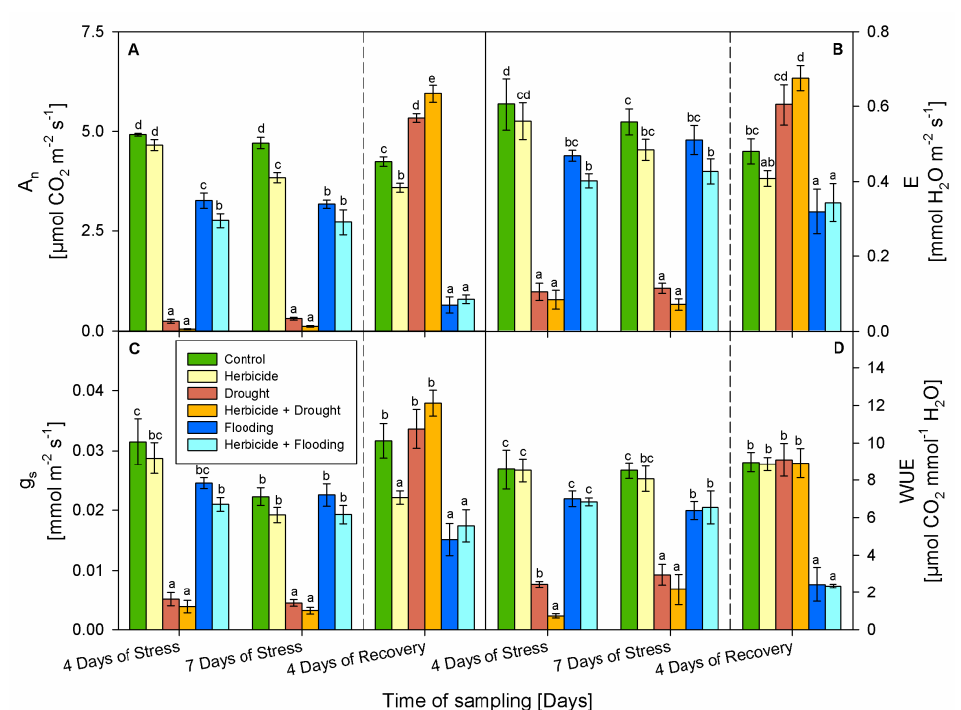
Figure 3. Leaf gas exchange parameters (( A ): net photosynthesis rate (An); ( B ): transpiration rate (E); ( C ): stomatal conductance (gs); ( D ): water use ef-ficiency (WUE)) of wheat plants treated with herbicide and subjected to drought or flooding stress. Data are mean values ± standard errors. Different small letters denote significant differences between mean values at p <